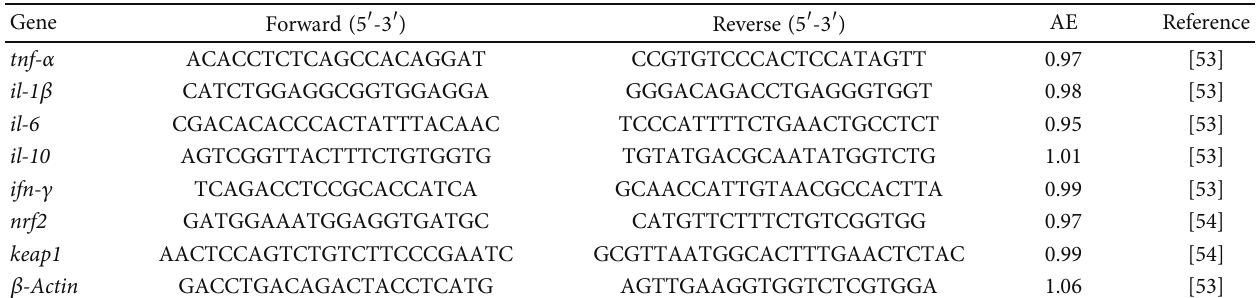
Table 4: Primers used in the quantitative real-time PCR analysis 1